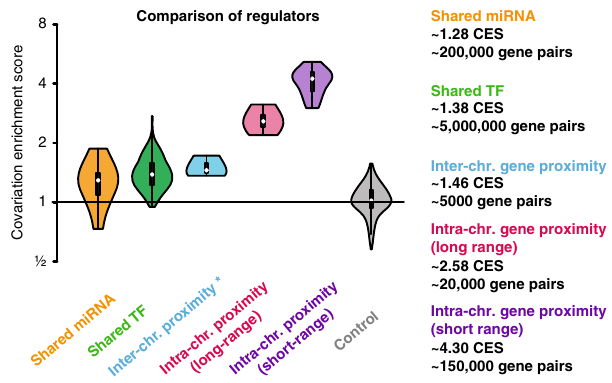
Fig. 3 Relative importance of miRNAs, transcription factors and nuclear proximity for covariations. Comparison of covariation enrichment (CES) scores for genes that are either regulated by the same miRNA, regulated by the same transcription factor or that are in nuclear proximity — divided into intrachromosomal and interchromosomal